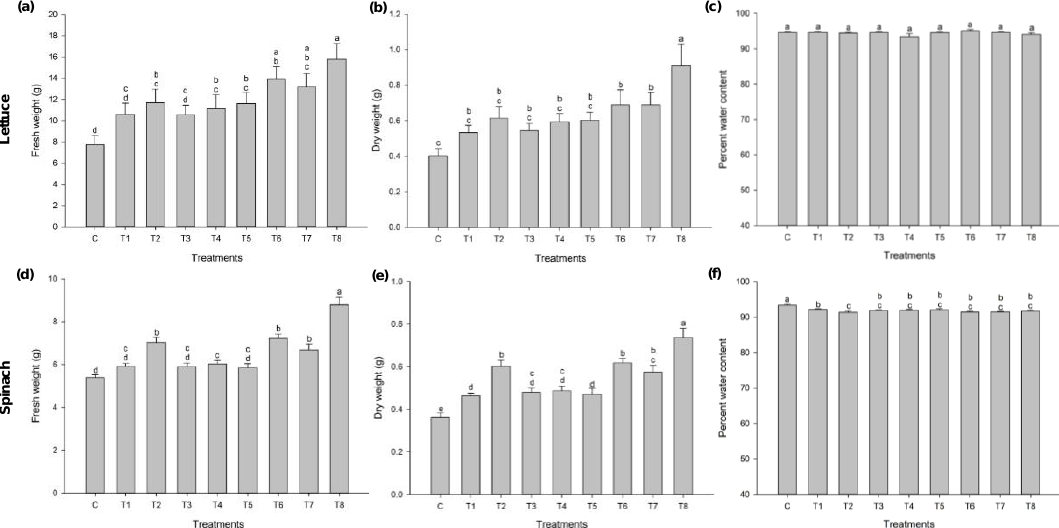
Figure 1. Effect of Ascophyllum nodosum extract (ANE) and Humic acid (HA) on fresh weight, dry weight, and percent water content of ( a – c ) lettuce and ( d – f ) spinach seedlings. Different combinations of ANE and HA were used as follows: C (control), T1 (0.1% ANE), T2 (0.25% ANE), T3 (0.2% HA), T4 (0.4% HA), T5 (0.1% ANE + 0.2% HA), T6 (0.1% ANE + 0.4% HA), T7 (0.25% ANE + 0.4% HA), and T8 (0.25% ANE + 0.2% HA). Each experiment was performed in triplicate, and each experimental unit had six plants. The average of the eighteen values were presented as mean ± SE and means represented by same letters were not significantly different at p ≤ 0.05.